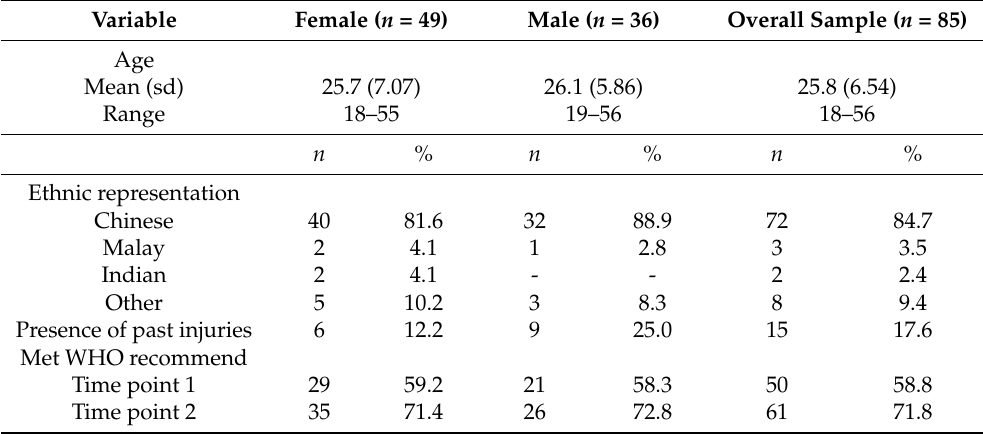
Table 1. Descriptive statistics of demographic